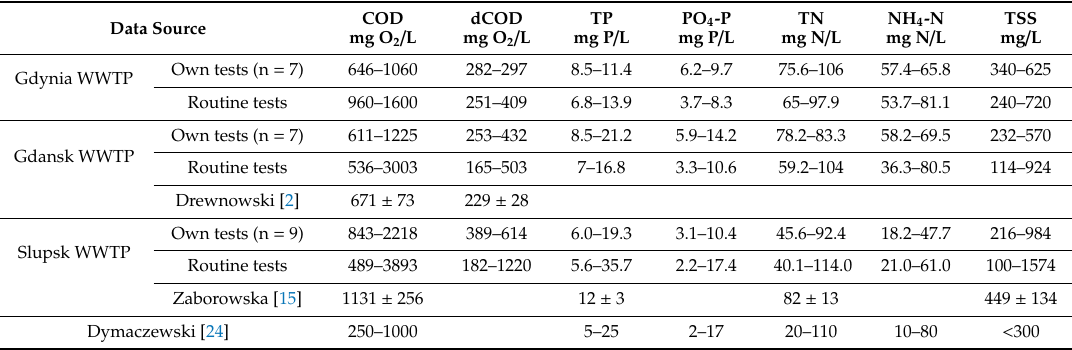
Table 1. Characteristics of raw municipal wastewater, n—number of